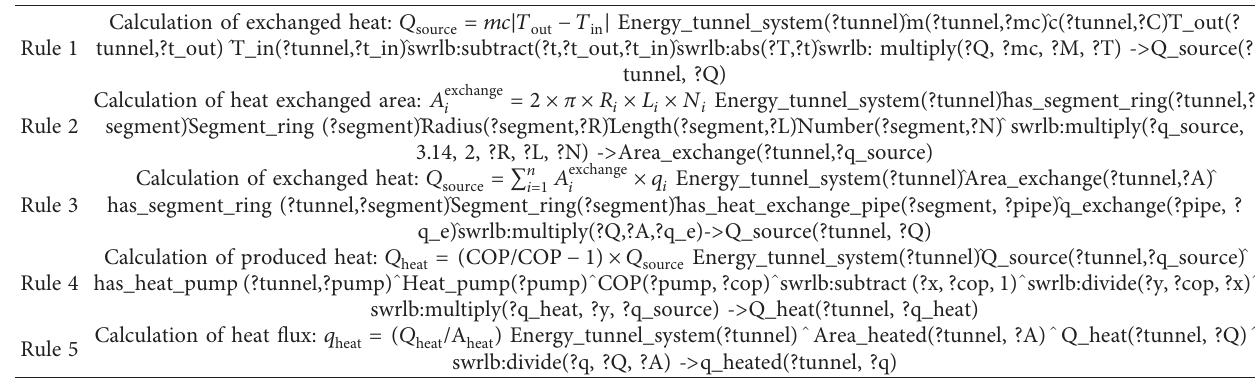
Table 5: SWRL rules for calculating exchanged heat and produced heat of the system.